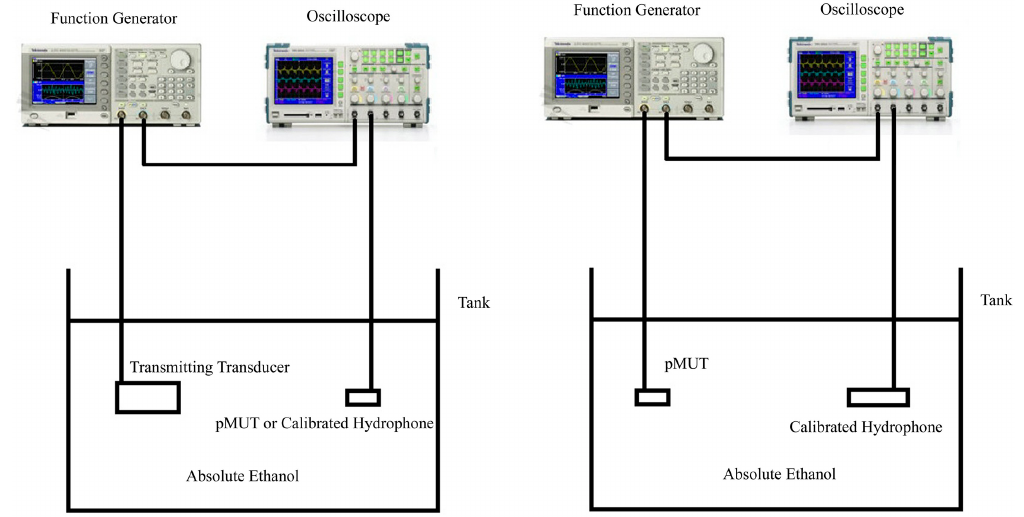
Figure 13. Receive ( left ) and transmit ( right ) sensitivity test of a pMUT.